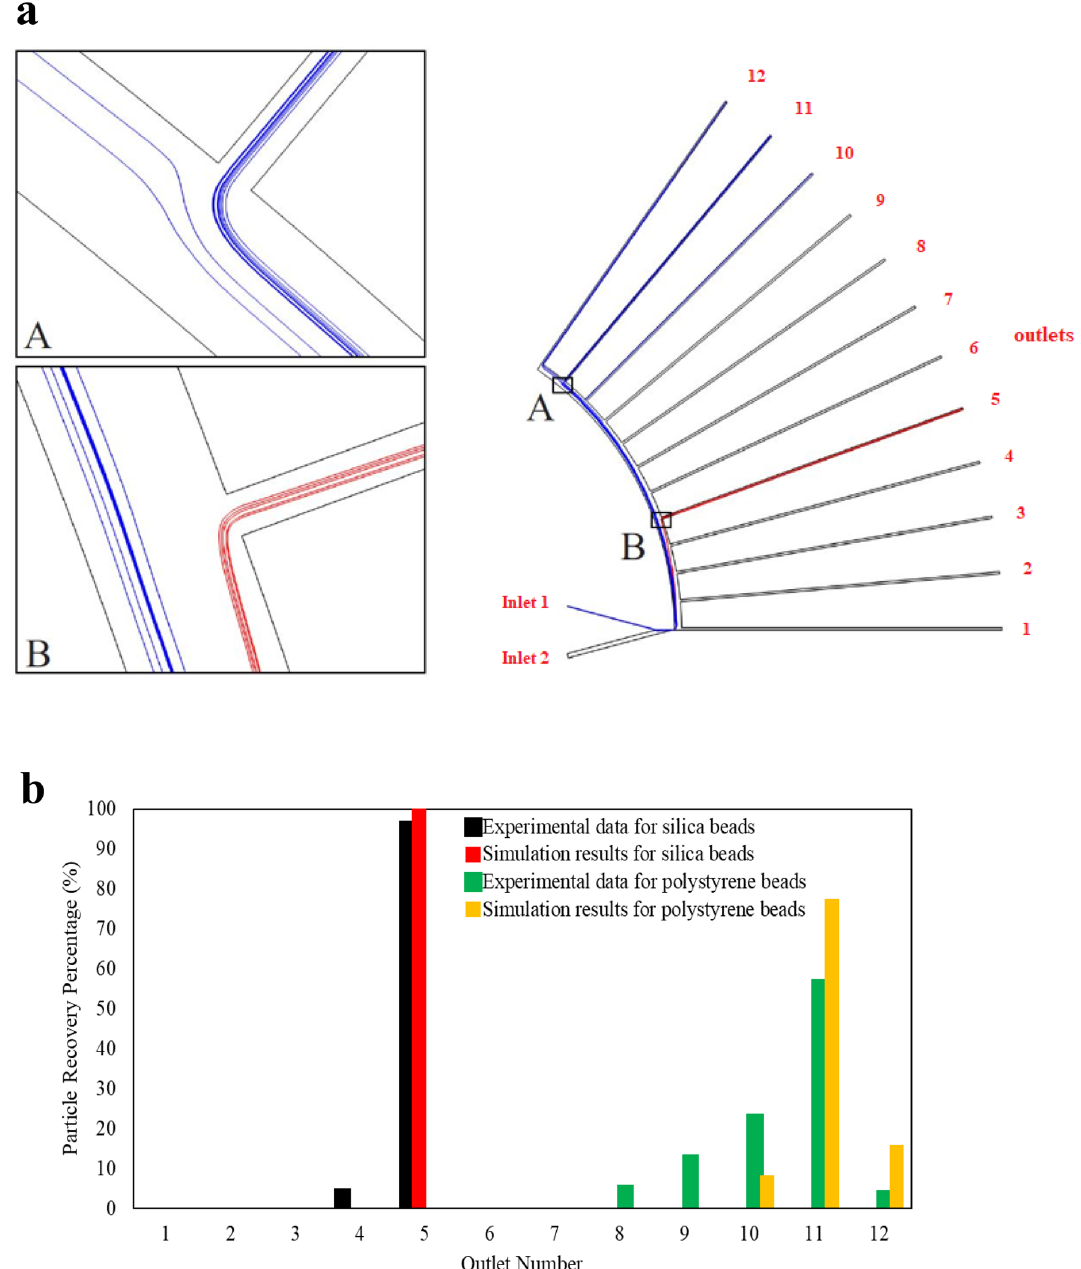
Figure 4. Comparison of simulation and experimental results of Morijiri et al . 18 at the rotational speed of 750 rpm. ( a ) Simulated trajectories of two particles with different sizes and densities (red: silica beads, and blue: polystyrene beads). ( b ) Recovery rates obtained by the numerical methods are compared with the